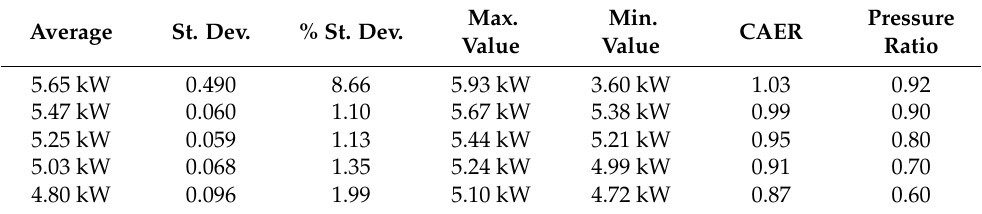
Table 1. Laboratory measurements of CAER (source: own representation).